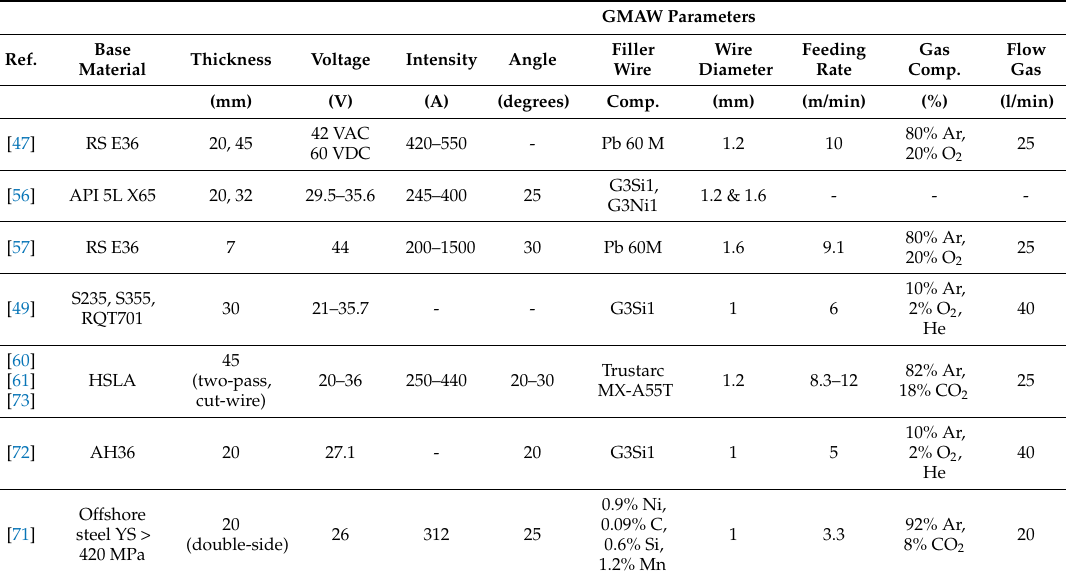
Table 9. Value range of parameters of arc welding process. GMAW